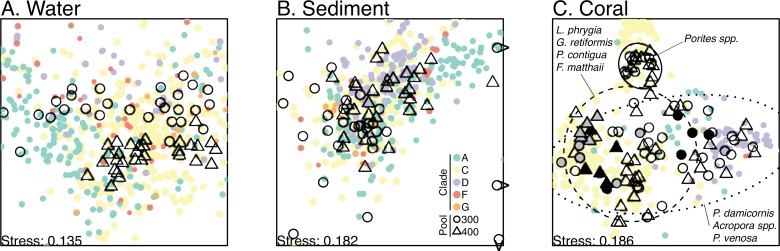
Differentiation of Symbiodinium communities between pools.NMDS biplots on Bray-Curtis dissimilarities are shown for water (A), sediment (B), and coral (C). Samples from pool 300 and pool 400 are represented by circles and triangles, respectively. Taxa are plotted in the same ordination space and colored by clade (A = green, C = yellow, D = purple, F = red, G = orange) to show their role in driving the differentiation between samples (e.g., clade D in association with sediment samples from pool 400). Three sediment samples are plotted with arrows indicating they lie outside the plot range. For corals, 90% confidence ellipses surround groups of species categorized qualitatively as low (< 0.4), intermediate (0.4–0.6), or high (> 0.6) overall dissimilarity (Table 1) to illustrate the range of observed variability in different coral species. Coral species whose symbiont communities were significantly different between pools (Table 1) are represented by filled symbols (gray = Psammacora contigua, black = Pavona venosa).